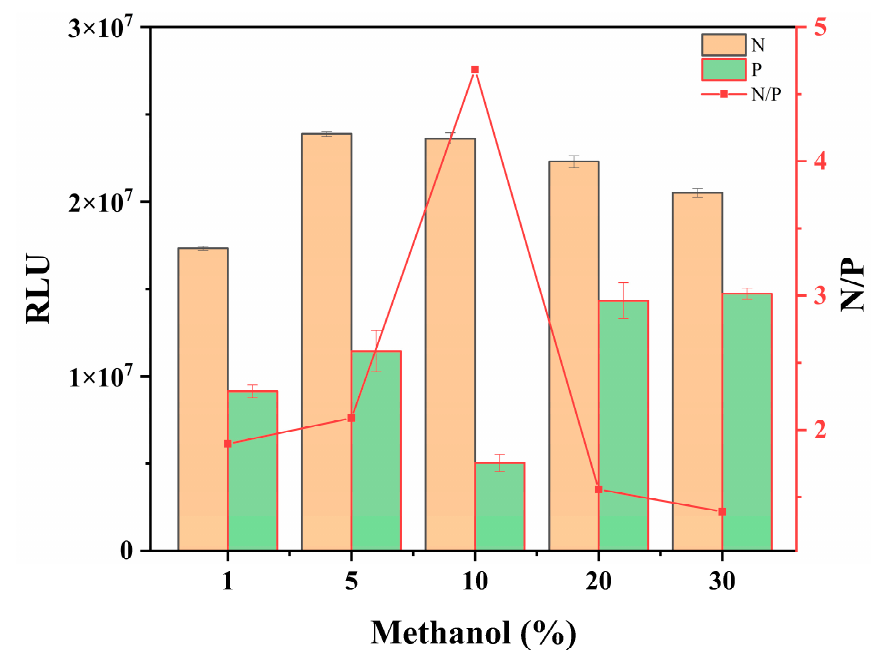
Figure 3. Effects of methanol on Cl-ELISA. The data are averages of three replicates. P: the RLU values of the positive wells (the concentration of IMI = 3.125 µ g/L), N: the RLU values of the negative values of the positive wells (the concentration of IMI = 3.125 μ g/L), N: the RLU values of the negative wells (the concentration of IMI = 0). wells (the concentration of IMI =